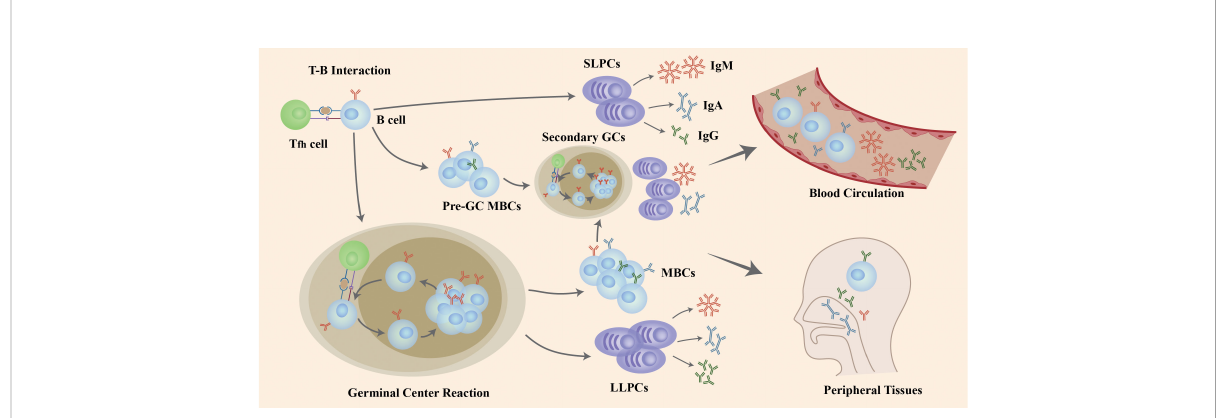
FIGURE 1 The role of B cells in COVID-19 infection and re-infection. Naïve B cells are activated via the help of folliculat T (Tfh) cells after the invasion of SARS-CoV-2 virus. Following T-B interaction, B cells go through rapid proliferation and differentiation, producing pre-germinal center memory B cells (pre-GC MBCs) and short-lived plasma cells (SLPCs) producing early antibodies with low af fi nity. Other B cells enter the germinal center (GC) to increase antibody af fi nity by clonal expansion and somatic hypermutation (SHM), and change the structure through class-switching recombination (CSR), resulting in long-lived plasma cells (LLPCs) and memory B cells (MBCs). If challenged with a second invasion or vaccination, both pre-GC MBCs and MBCs generated after GC reactions differentiate into plasma cells or generate a second GC in a short period of time to produce high-af fi nity antibodies. Those B cells and antibodies secreted enter the blood circulation and peripheral tissues like mucosa to defend against viral infection and re-infection. Figure adapted from